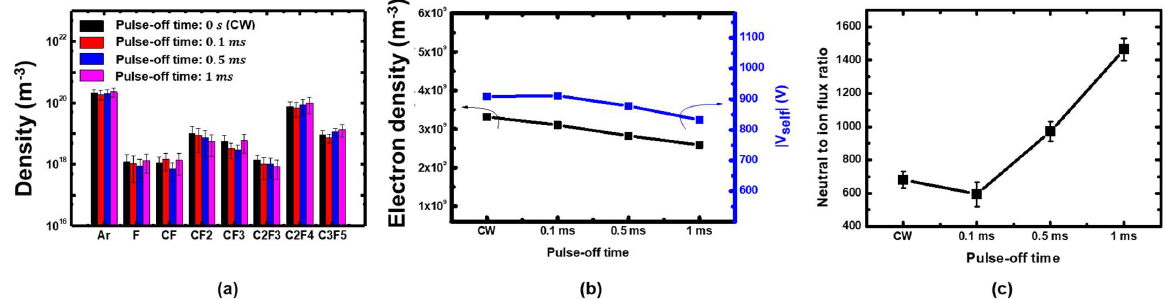
Figure 6. ( a ) Absolute neural species densities, ( b ) electron densities and self-bias voltages, ( c ) calculated neutral to ion flux ratios based on the measurement data in the pulse-modulated plasmas with various pulse-off time in C 4 F 8 20%.